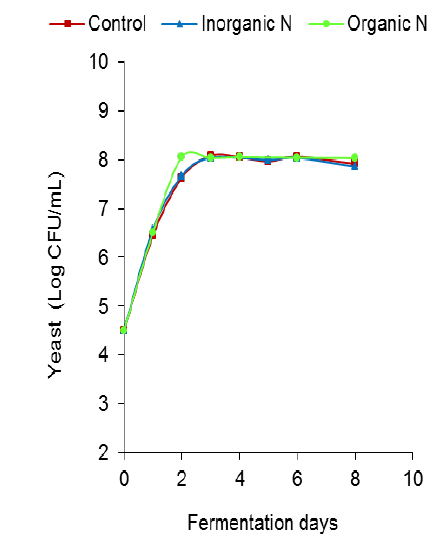
Figure 1. Evolution of density ( A ) and yeast population ( B ) during AF carried out with different nitrogen addition.